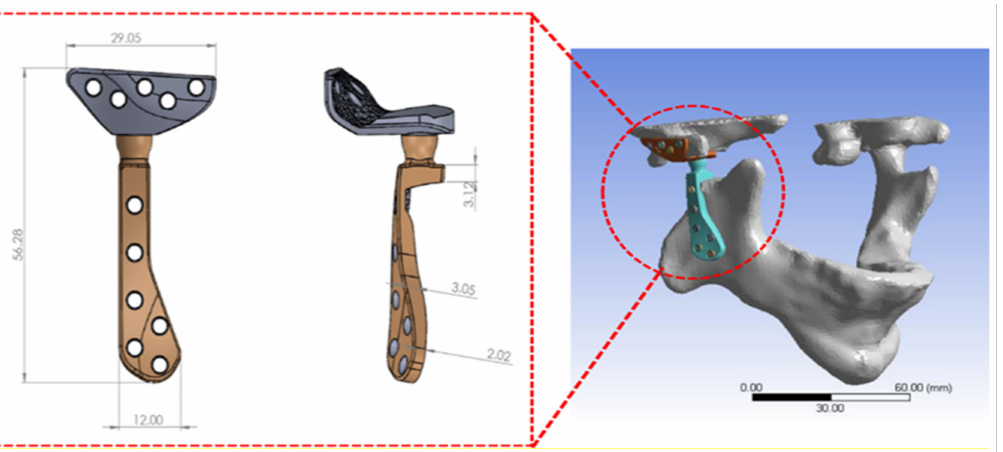
Figure 3. Solid works design of patient-specific TMJ implant with schematic of model in actual